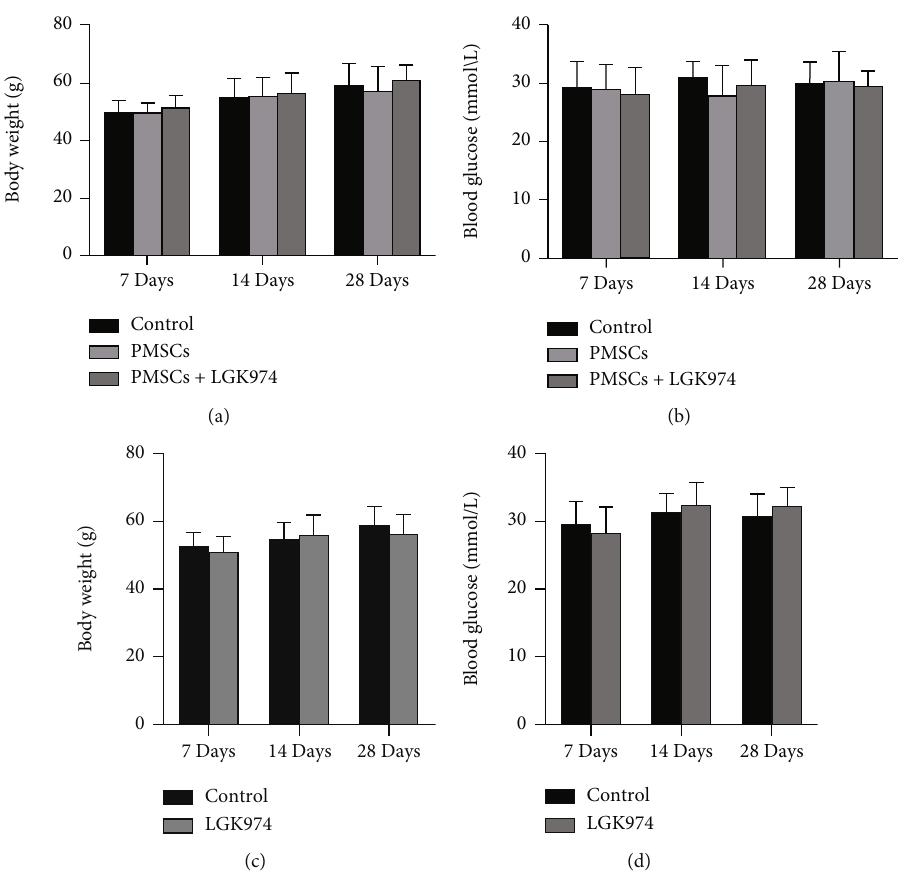
Figure 3: Blood glucose and body weight: (a, c) blood glucose (mmol/L); (b, d) body weight (g). No signi fi cant di ff erence in body weight and blood glucose was noted between the control group, PMSC group, and PMSC+LGK974 group at 7, 14, and 28 days. No signi fi cant di ff erence between the control group and LGK974 group at 7, 14, and 28 days.